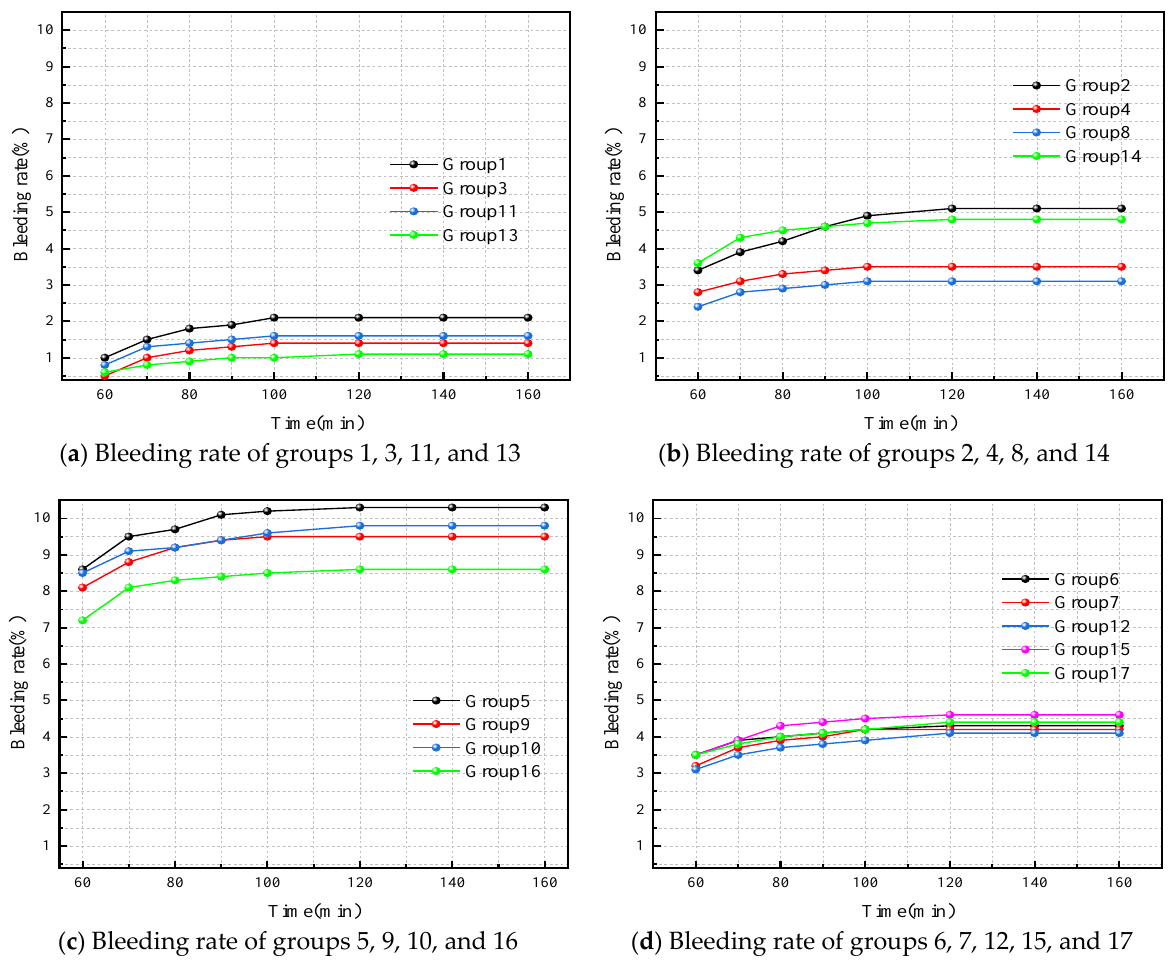
Figure 3. Bleeding rate of slurry with different components. ( a ) Bleeding rate of groups 1, 3, 11, and 13; ( b ) Bleeding rate of groups 2, 4, 8, and 14; ( c ) Bleeding rate of groups 5, 9, 10, and 16; ( d ) Bleeding rate of groups 6, 7, 12, 15, and 17.